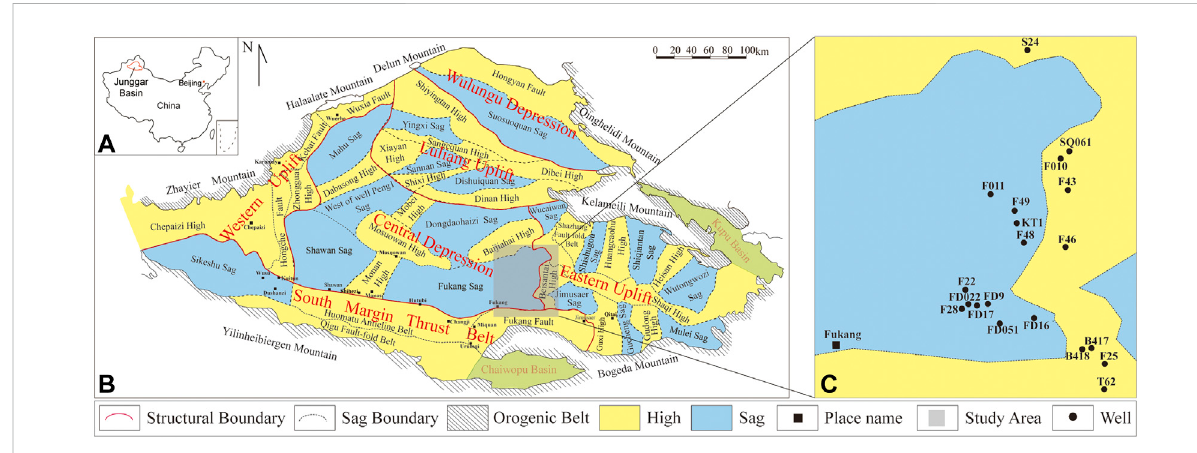
FIGURE 2 Generalized stratigraphic column of the eastern Junggar Basin (modi fi ed from Cao et al., 2017; Bai, et al., 2017; He et al., 2018).